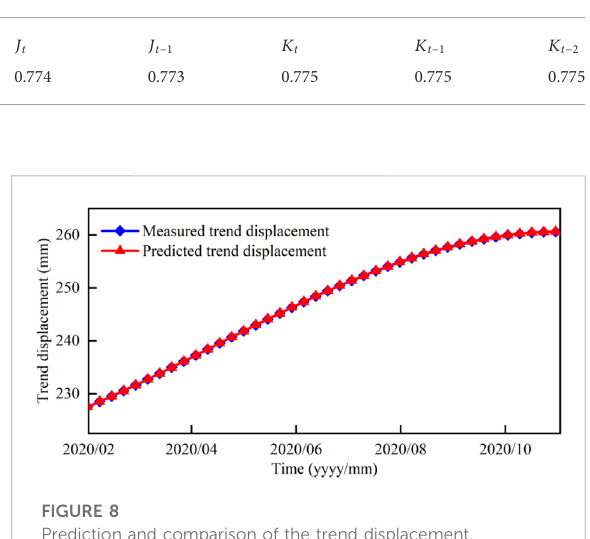
FIGURE 7 Prediction and comparison of the fl uctuation displacement.